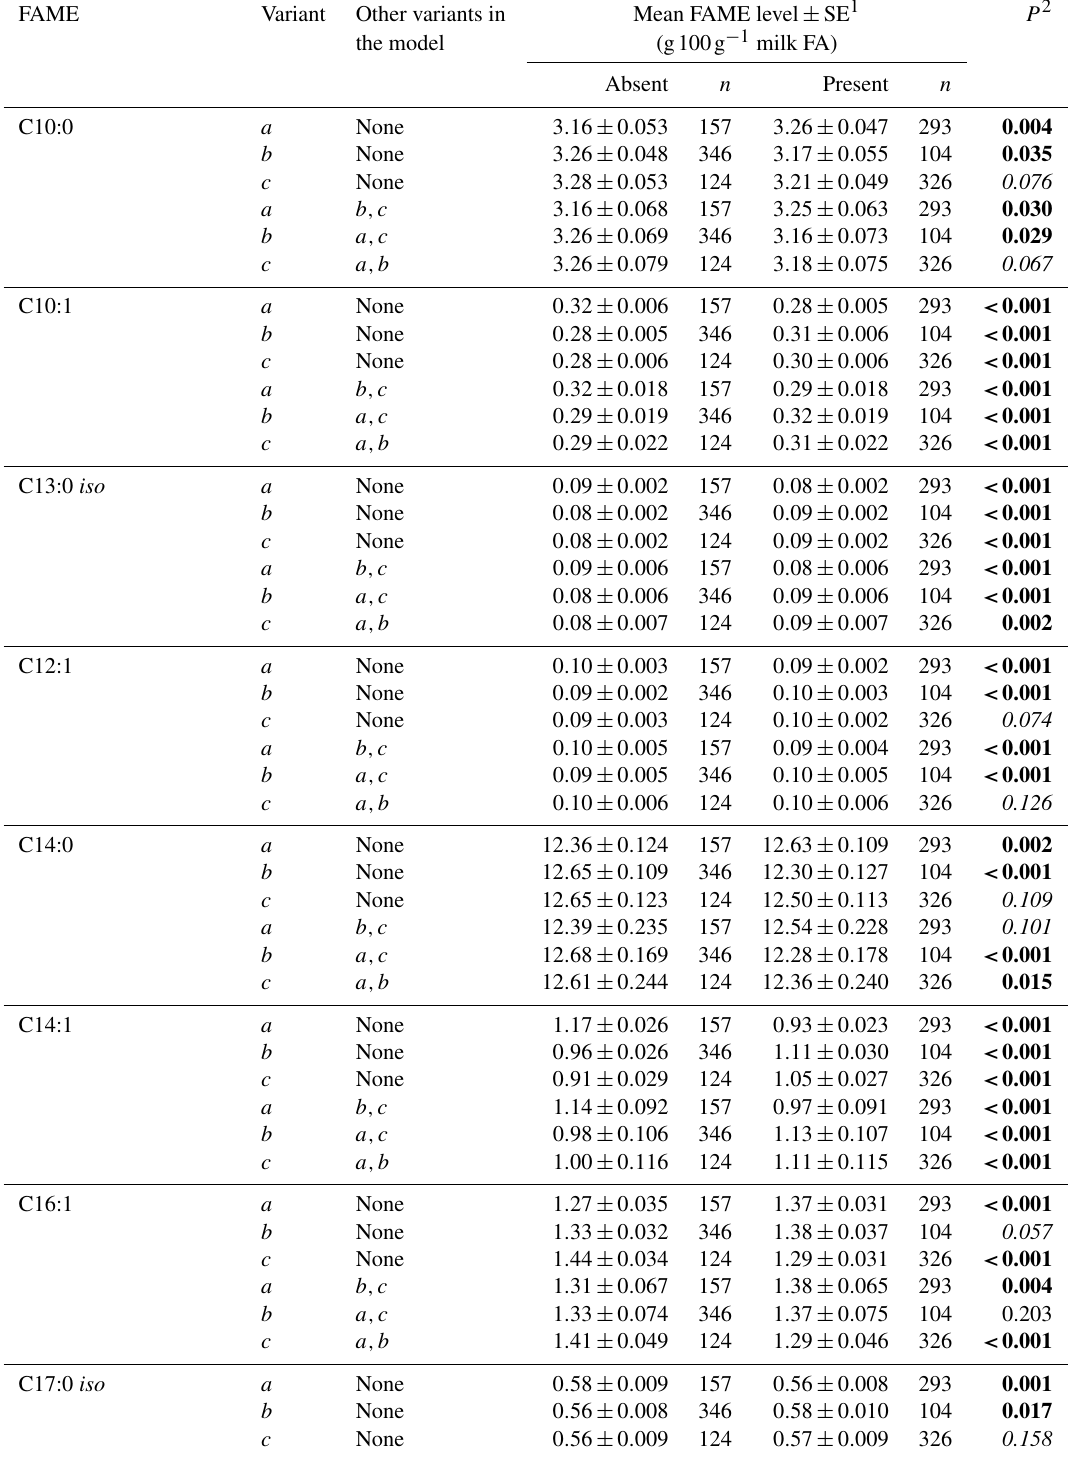
Table 3. Association between individual fatty acid levels and SCD 3 (cid:48) -UTR variation. FAME Variant Other variants in the